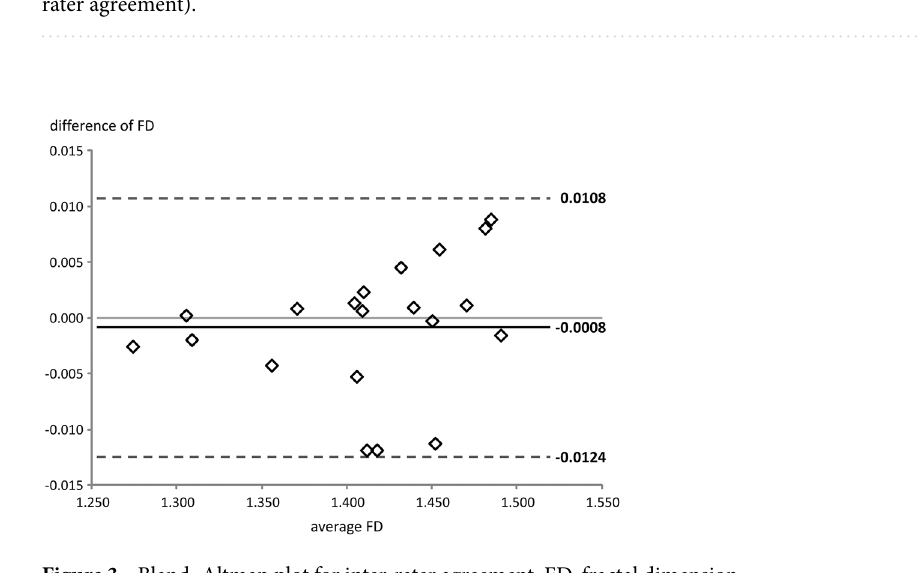
Figure 3. Bland–Altman plot for inter-rater agreement. FD, fractal